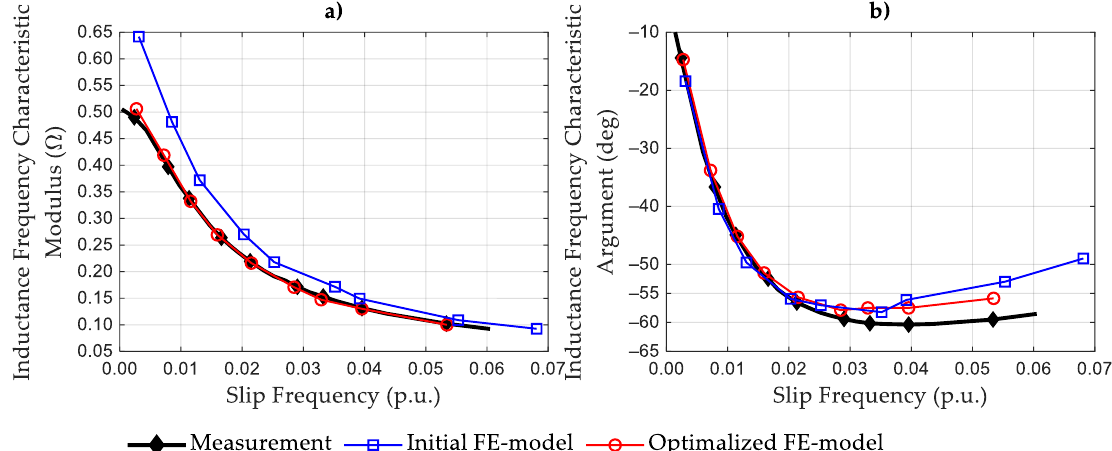
Figure 4. The inductance frequency characteristics of the tested IM determined based on the data derived from the LCT performed experimentally and with the use of the FEM: ( a ) modulus and ( b ) argument.